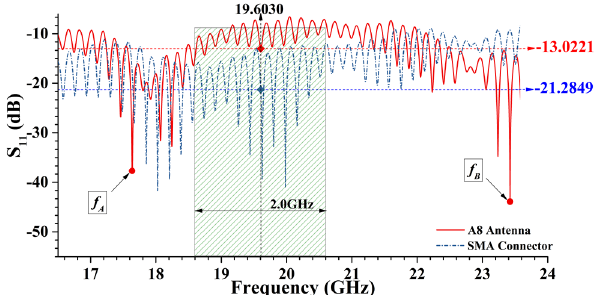
Figure. 8. The no-load S 11 of SMA connector and S 11 magnitude of A 7 antenna. The hashed area represents the expected window which A 7 resonant frequency must be